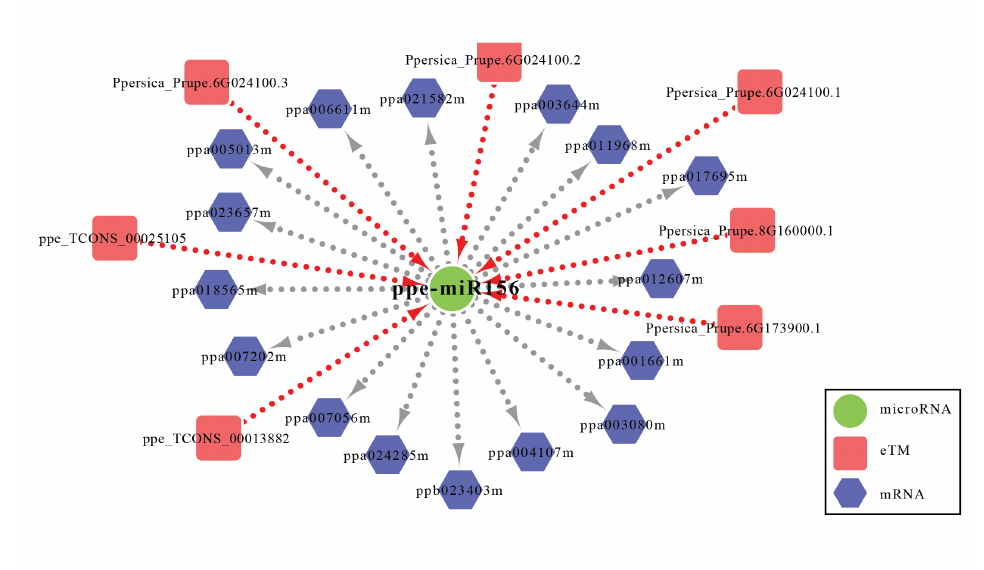
Figure 2: Computationally predicted eTM-miRNA-mRNA regulatory network module for the development of peach fruit. ETMs, mRNAs and miR156 are represented by red, blue and green colored nodes, respectively. In the proposed gene network, while the red dotted lines show putative eTM-miRNA interactions, the grey ones indicate potential rela- tionships between miR156 and its target mRNAs.